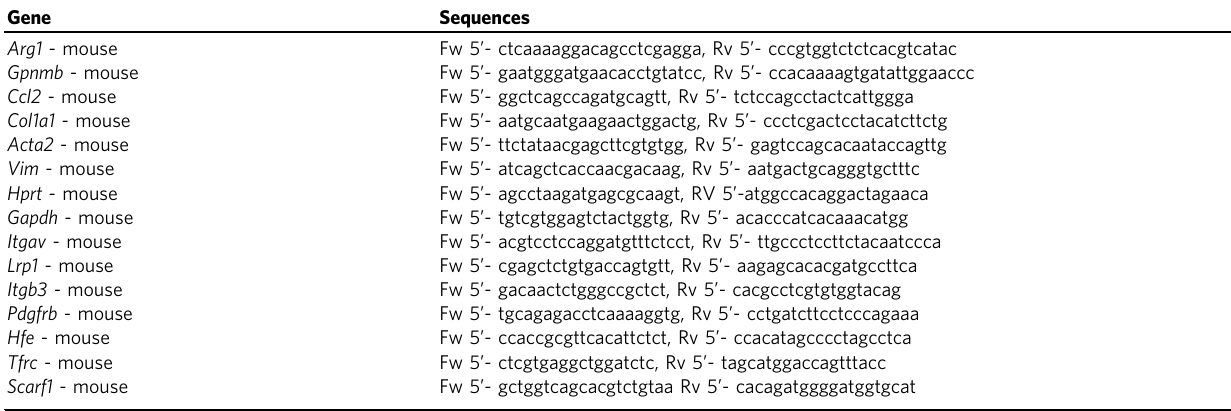
Table 1 qPCR primers